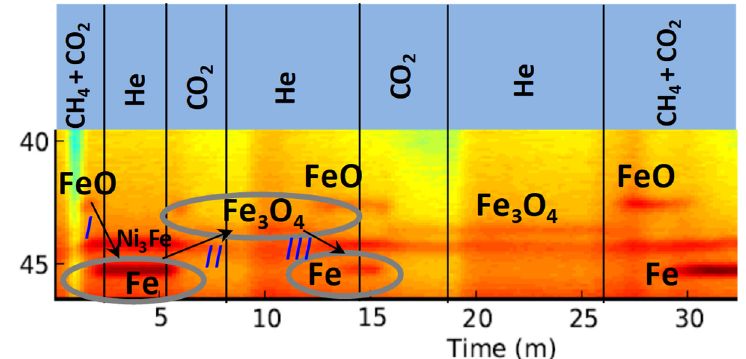
Figure 4. In situ XRD patterns collected from Ni/Fe 2 O 3 –CeO 2 during reduction/oxidation cycles at 873 K. Transitions are indicated by arrows: FeO reduction (I) and re-oxidation (II), disappearing Fe 3 O 4 diffraction, re-emergence of first FeO and then Fe in He flow after CO 2 re-oxidation (III). Gas environments are indicated above the two-dimensional (2D) patterns [48].